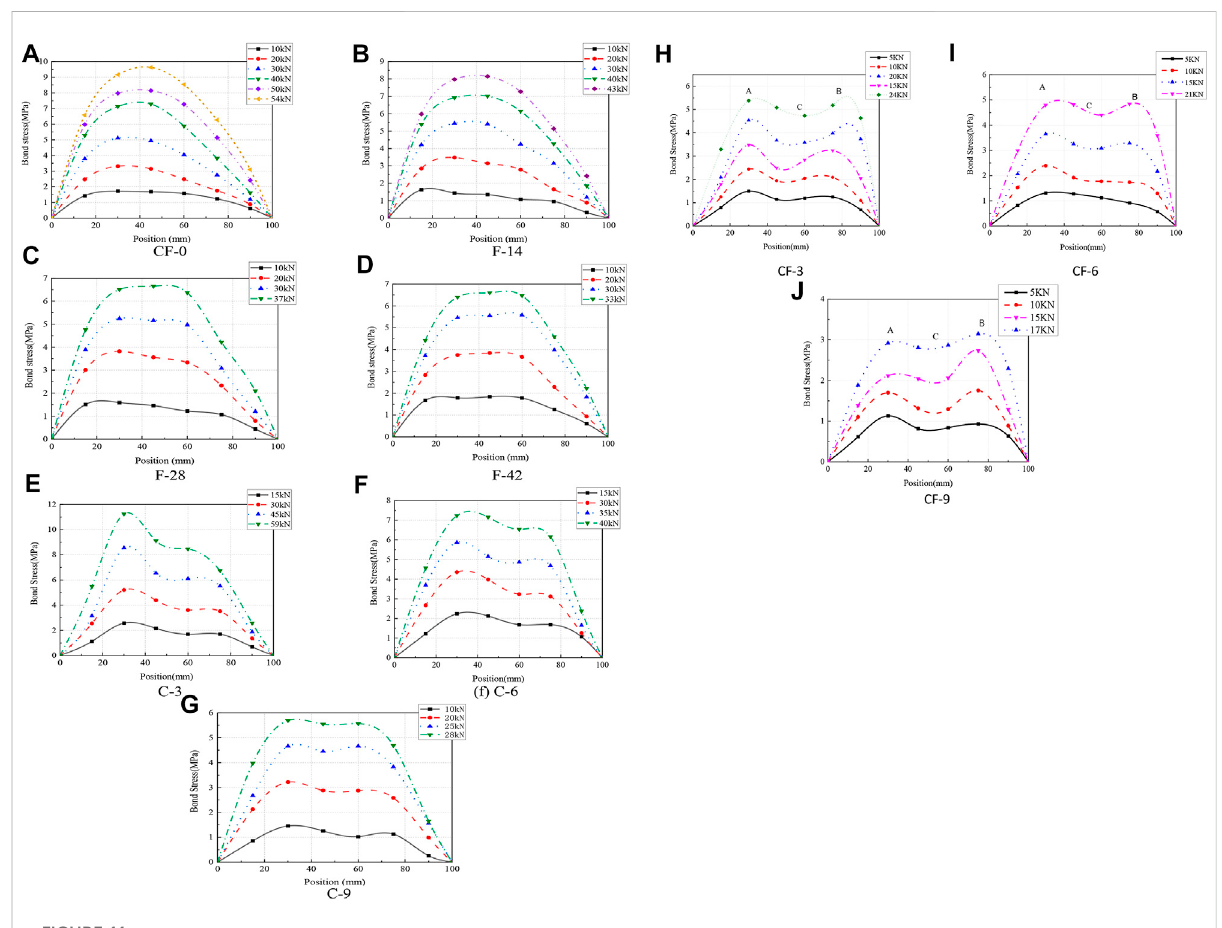
FIGURE 11 Bond stress distribution.